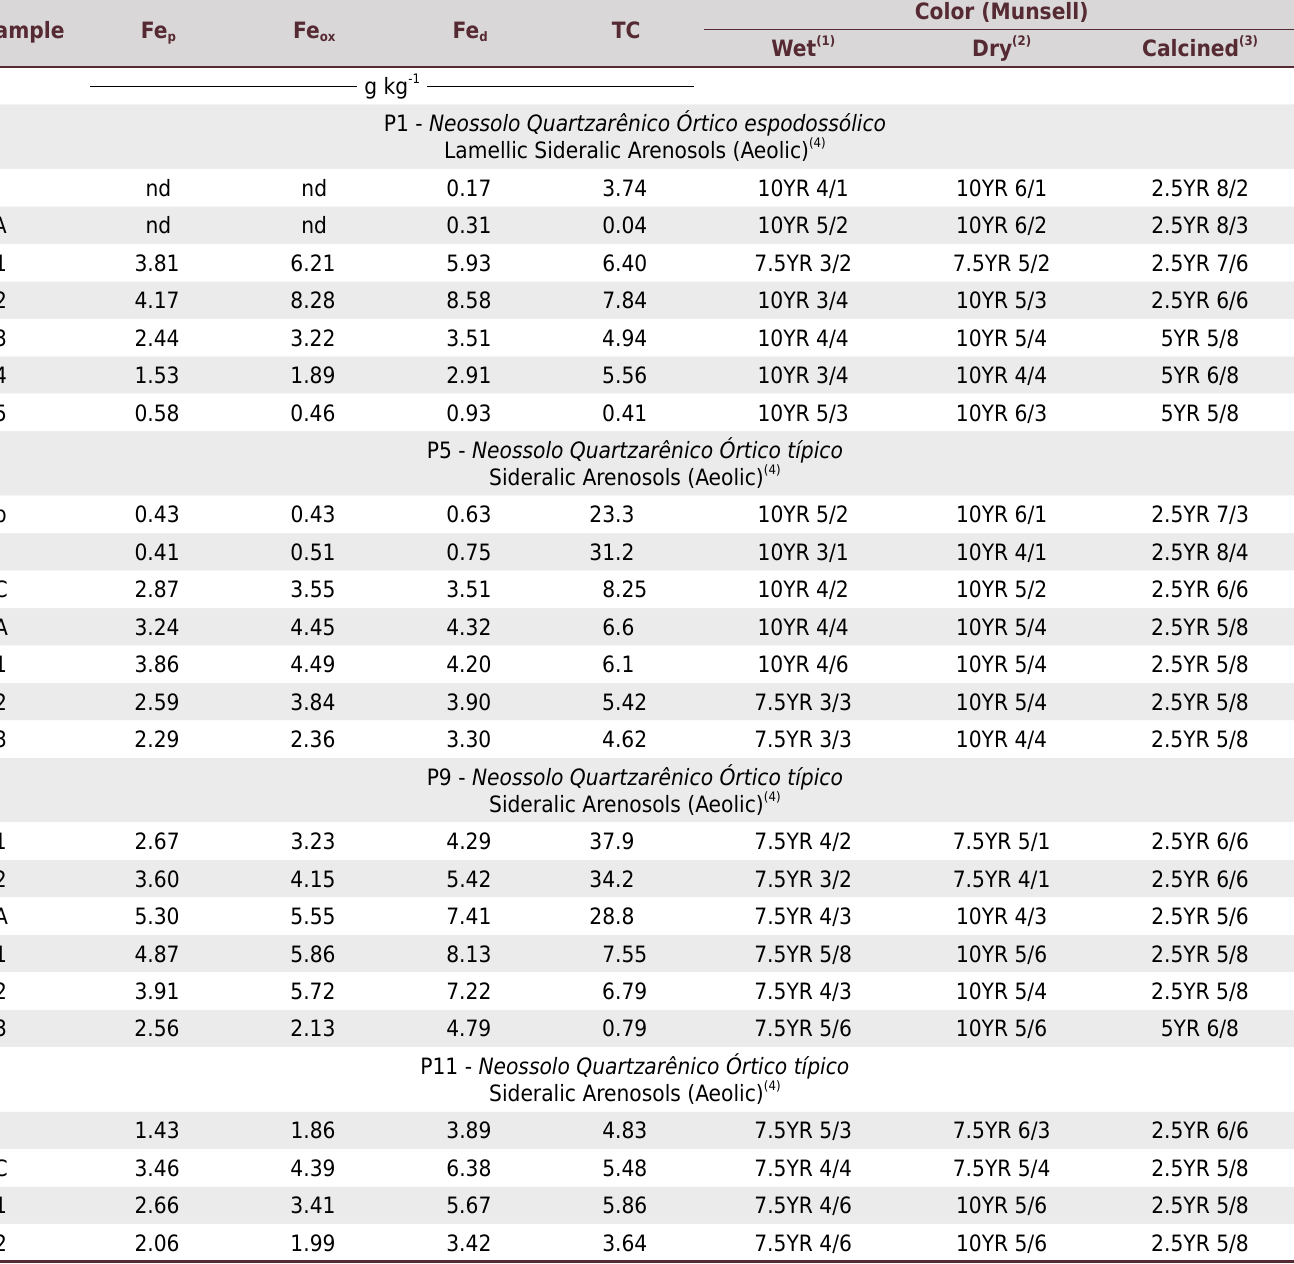
Table 2. Analytical data of total carbon (TC) and Fe contents in soil samples (Quartzipsamments) extracted with sodium pyrophosphate (F ep ), acid ammonium oxalate (Fe ox ), dithionite-citrate-bicarbonate (Fe d ), and their colors obtained in wet basis, dry basis, and after calcination procedure